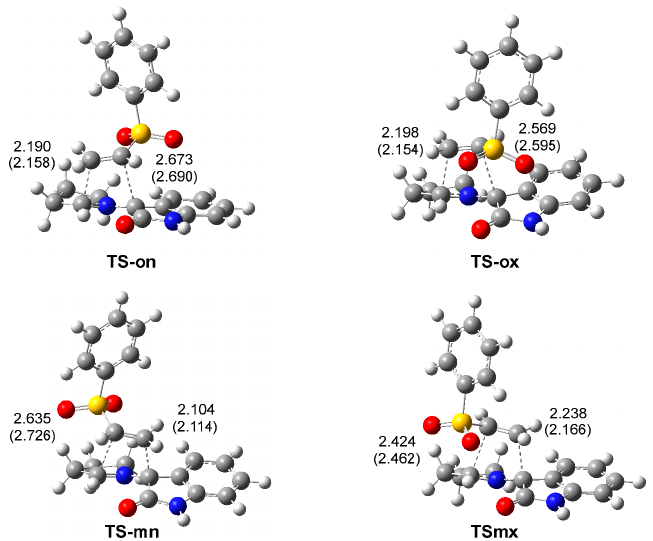
Figure 3. ω B97X-D/6-311G(d,p) geometries of the TSs involved in the 32CA reaction of AY 22 with phenyl vinyl sulphone 20 . Distances are given in angstroms, Å. Distances in methanol are given in parentheses.